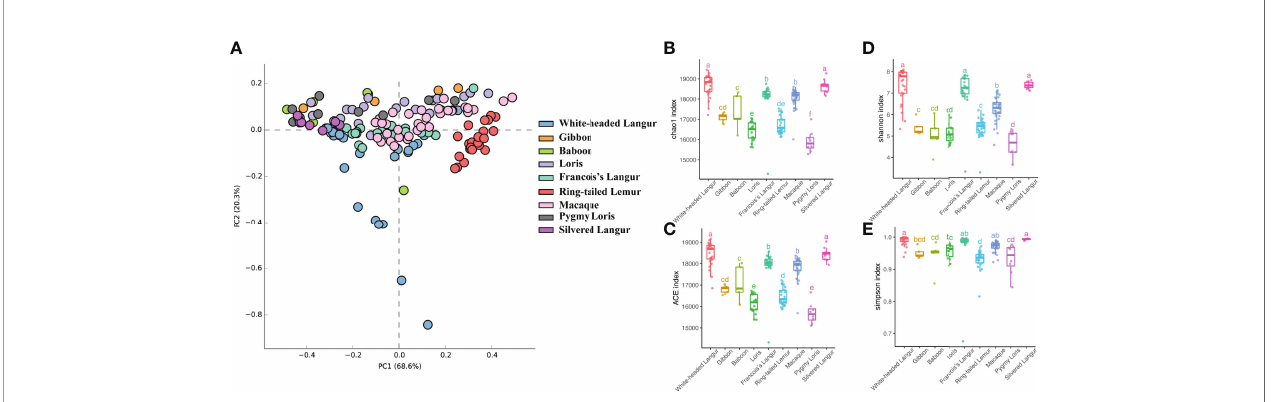
FIGURE 1 | PCoA of the gut mirobiome and boxplots of the diversity index and richness index. (A) PCoA of structure differentiation and interindividual similarity on the gut microbiota of nine primates. (B) Boxplots of the Chao1 index. (C) Boxplots of the ACE index. (D) Boxplots of the Shannon index. (E) Boxplots of the Simpson